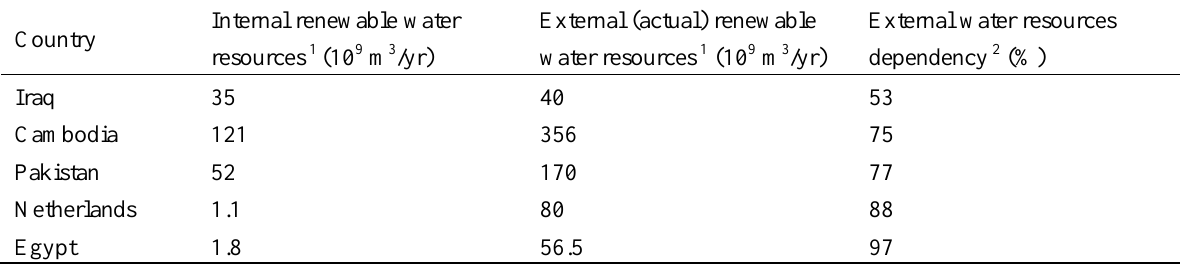
Table 2. Dependency on incoming river flows for some selected